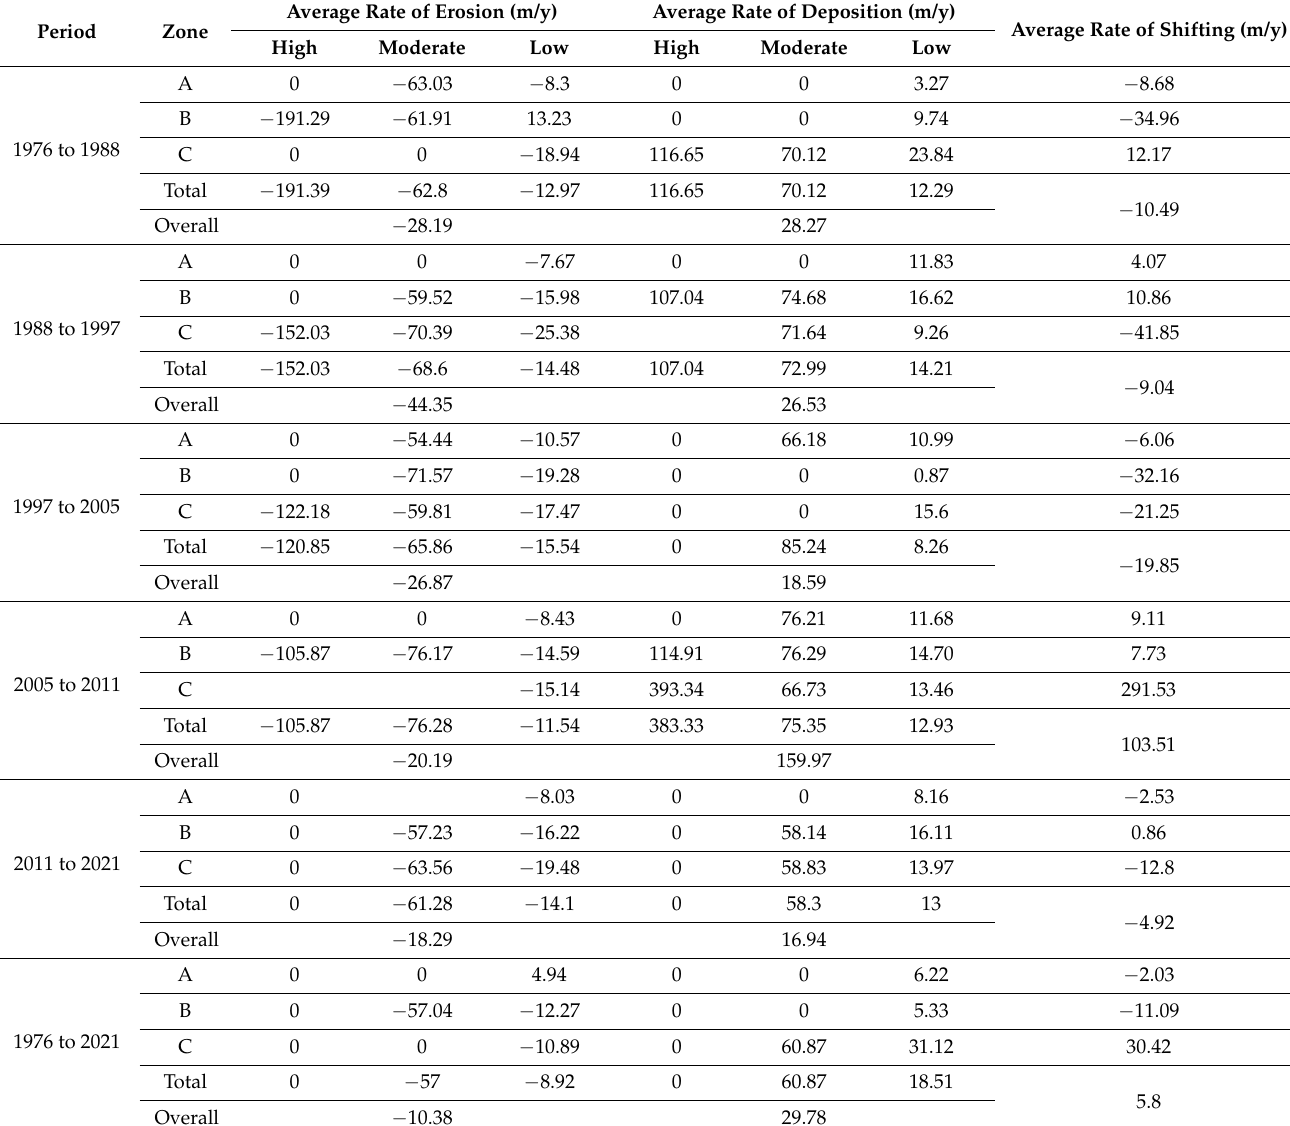
Table 4. Left bank shifting rate of the Jia Bharali River using EPR approach of DSAS